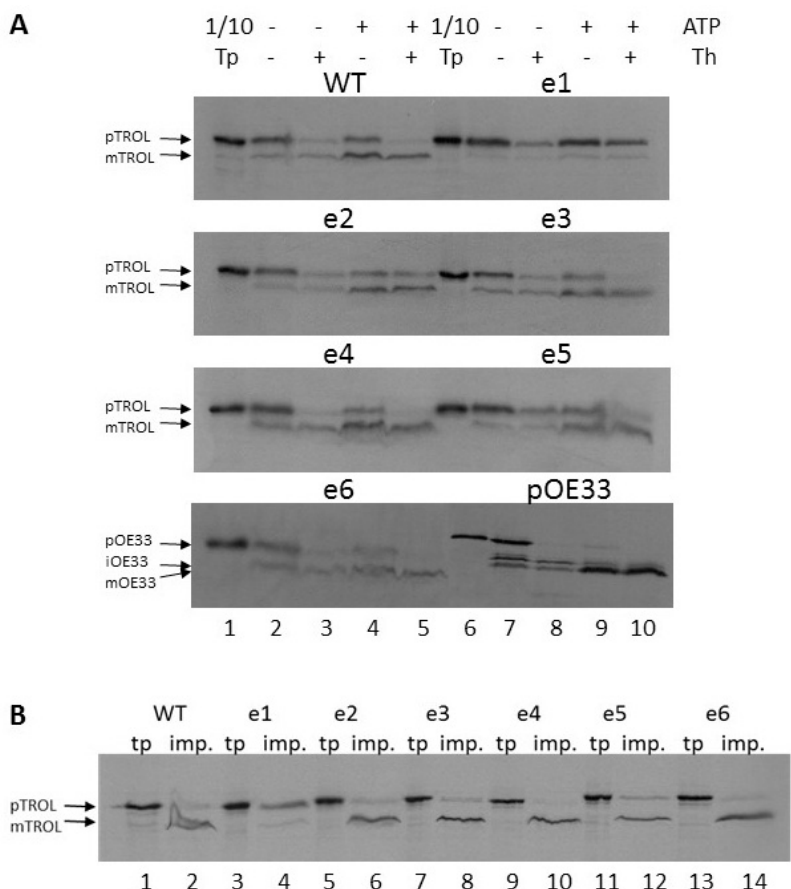
Figure 2. ( A ) Wt TROL and its presequence mutants e1–e6 are imported into pea chloroplasts. In vitro synthesized [ 35 S]-TROL and e1–e6, as well as the control protein pOE33 from thylakoid lumen were incubated with isolated intact chloroplasts at 25 ° C for 20 min, in a standard import reaction containing 3 mM ATP (lanes 4, 5, 9, and 10) or without ATP (lanes 2, 3, 7, and 8). After import, samples were re-isolated on a Percoll cushion and treated with 0.5 µg thermolysin (Th) per µg chlorophyll (lanes 3, 5, 8, and 10). Untreated samples are shown in lanes 2, 4, 7, and 9. The results were analyzed by SDS ⁄ PAGE. Lanes 1 and 6 represent 10% of the translation product (Tp) used for the import reactions. The positions of pTROL, mTROL, pOE33, iOE33, and mOE33 are indicated by arrows. ( B ) Comparison of import of TROL and its presequence mutants e1–e6 into chloroplasts. In vitro synthesized [ 35 S]-TROL and e1–e6 were incubated with isolated intact chloroplasts at 25 ° C for 20 min, in a standard import reaction containing 3 mM ATP. After import, samples were re-isolated on a Percoll cushion and treated with 0.5 µg thermolysin (Th) per µg chlorophyll (lanes 2, 4, 6, 8, 10, 12, and 14). The results were analyzed by SDS ⁄ PAGE. Lanes 1, 3, 5, 7, 9, 11, and 13 represent 10% of the respective translation product. The positions of pTROL and mTROL are indicated by arrows.